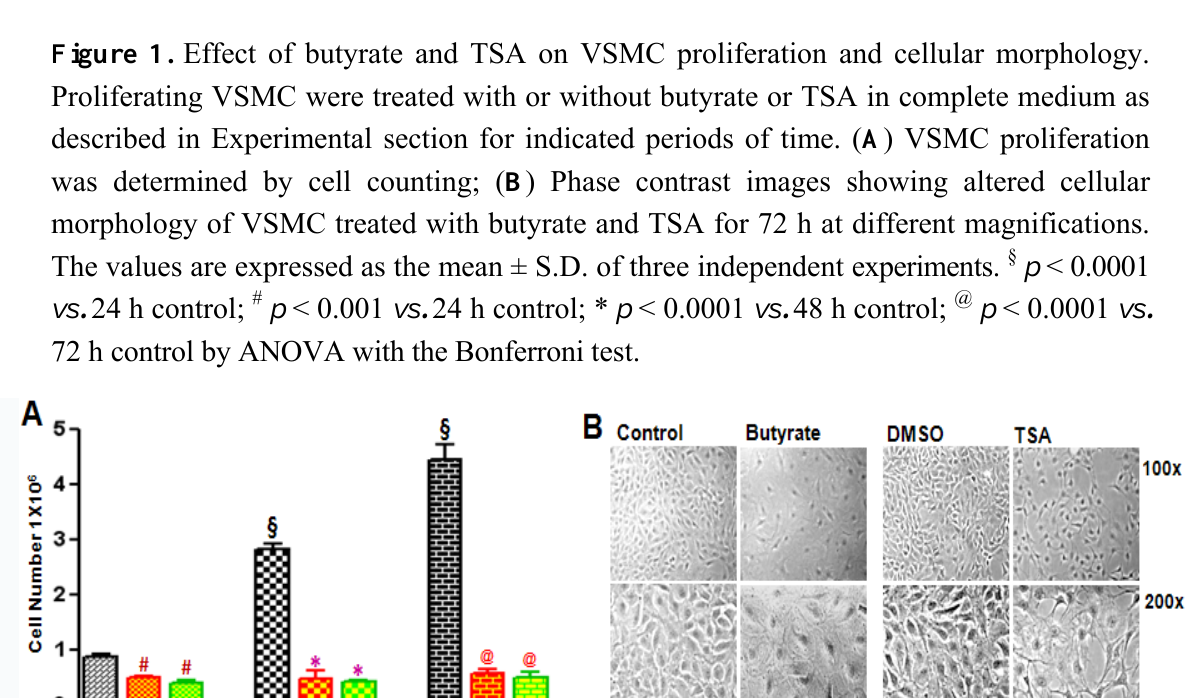
Figure 1. Effect of butyrate and TSA on VSMC proliferation and cellular